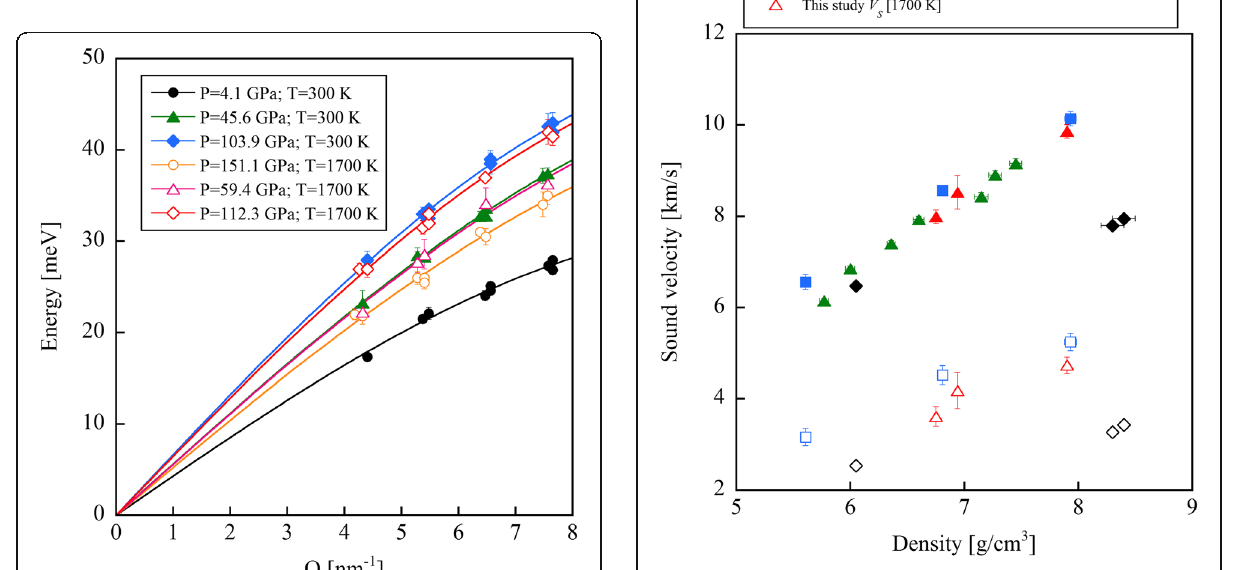
Fig. 5 Sound velocities of wüstite at 300 K and 1700 K as a function of density. For comparison, velocities at 300 K reported by Badro et al. (2007) and Wicks et al. (2017) are